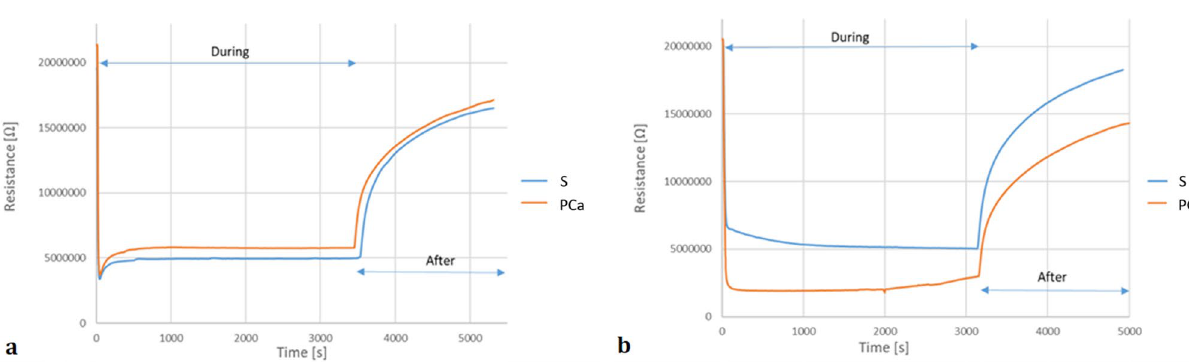
Figure 2. Example of eNose signals relevant to the analysis of urine headspaces from PCa patient and controls enriched at ( a ) 37 °C and ( b ) 60